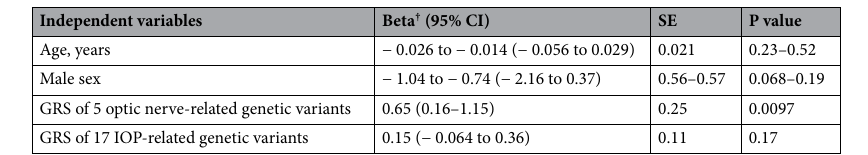
Table 3. Results of a multiple linear regression analysis with pattern standard deviation of automated static perimetry* in the worse eye as a dependent variable in patients with primary open-angle glaucoma. CI confidence interval, SE standard error, GRS genetic risk score, IOP intraocular pressure. *Humphrey field analyzer 30–2 (HFA30-2), † Regression coefficient. F change = 1.3–2.9, P =